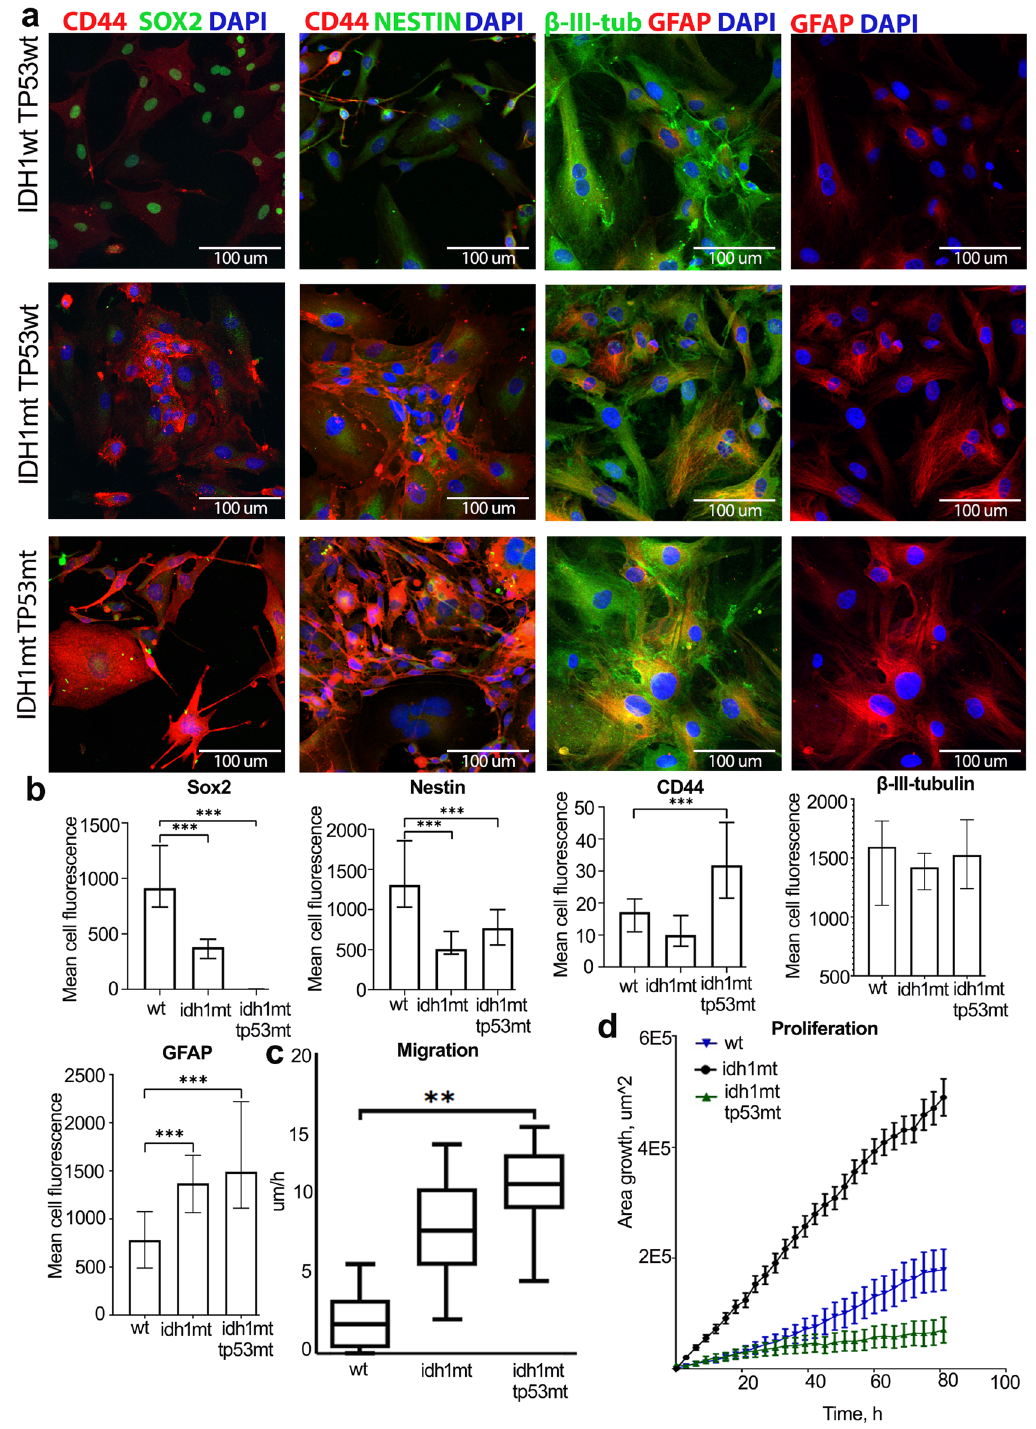
Figure 6. Stemness, migration and proliferation of wild-type and mutant cell cultures. ( A ) Staining of glioma primary cells (IDH1wt_TP53wt cells – superior pictures, IDH1mt_TP53wt – middle pictures, IDH1mt_TP53mt – inferior pictures) for stem (Sox2 and Nestin), migration (CD44) markers, and differentiation markers (GFAP and β-III-tubulin). CD44 and GFAP displayed in red, Sox2, Nestin, and β-III-tubulin in green, DAPI in blue. ( B ) Sox2, CD44, Nestin, GFAP and β-III-tubulin expression by primary glioma stem cells. Expression was counted as mean fluorescence intensity for IDH1wt and TP53wt (wt) cells, IDH1mt-cells, and IDH1mt-TP53mt cells. Data presented as median ± Q1/Q3, statistical significance was set to p < 0.05. ( C ) Migration velocity measured in um per hour of wt-cells, IDH1mt-cells, and IDH1mt-TP53mt cells. The data presented as mean ± SD for n = 4 replicates, statistical significance was set to p < 0.05. ( D ) Proliferation speed measured in area of growth (um2) per hour of wt-cells, IDH1mt-cells, and IDH1mt-TP53mt cells. The data presented as mean ± SD for n = 4